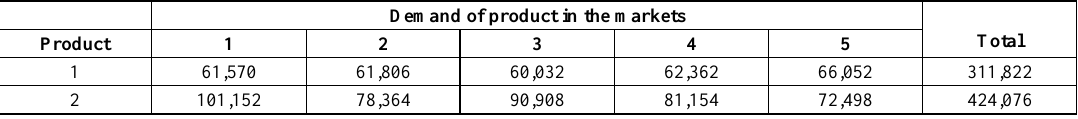
Table 1. Typical demand of 2 products out of total 4 at various